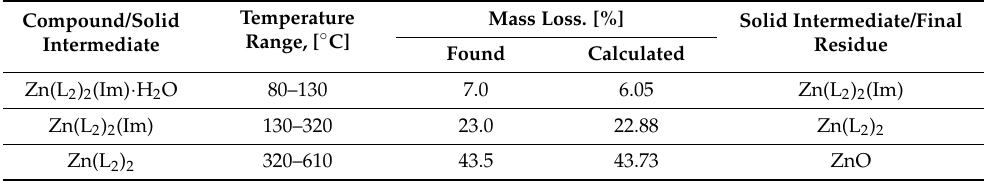
Table 11. TG-DTG analysis data of decomposition of Zn(L 2 ) 2 (Im) · H 2 O.